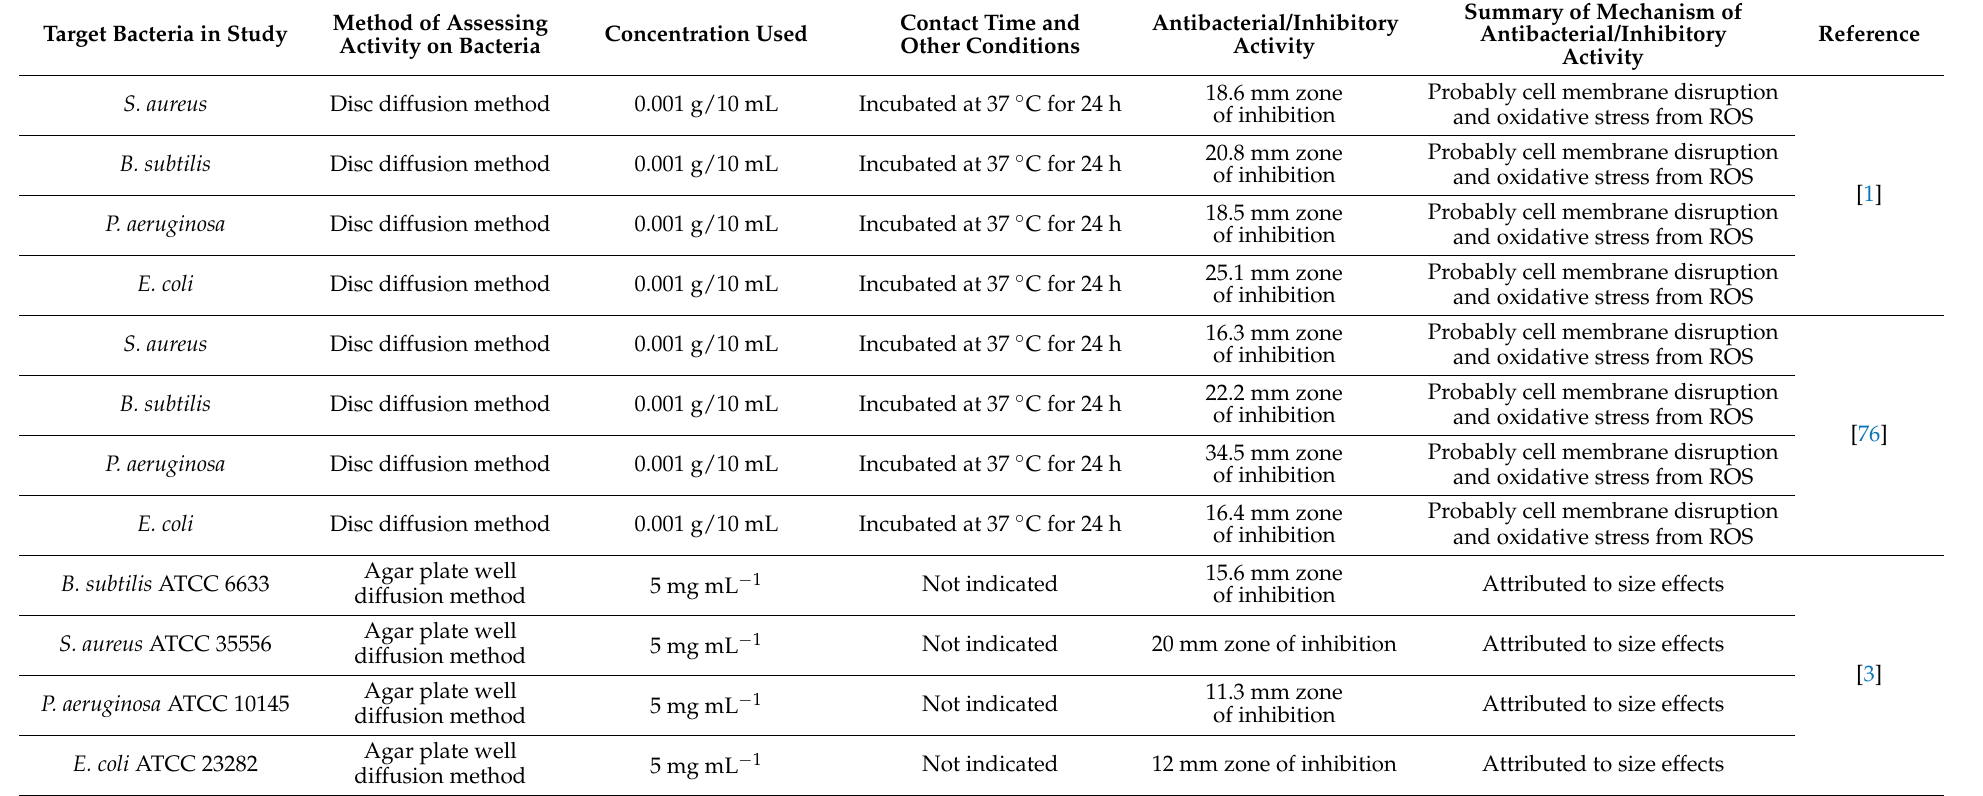
Table 3. Cobalt oxide nanoparticles and bacteria remediation